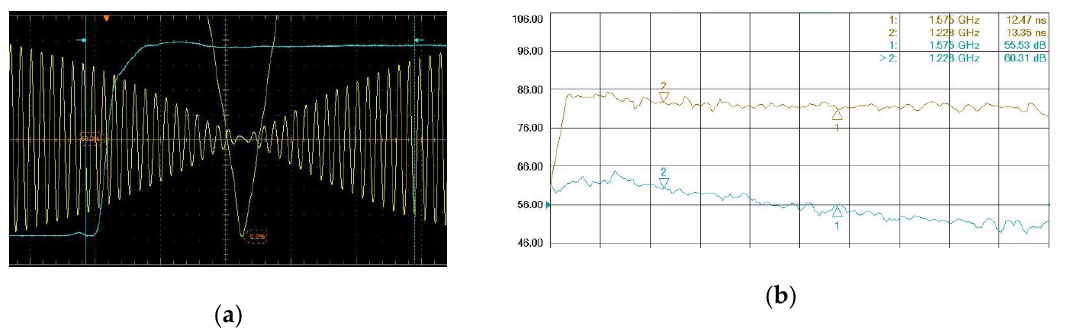
Figure 5. The calibration result of simulator: ( a ) time-to-code (TtC) measurement by the oscilloscope; ( b ) amplifiers delay measurement by the vector network analyzer.